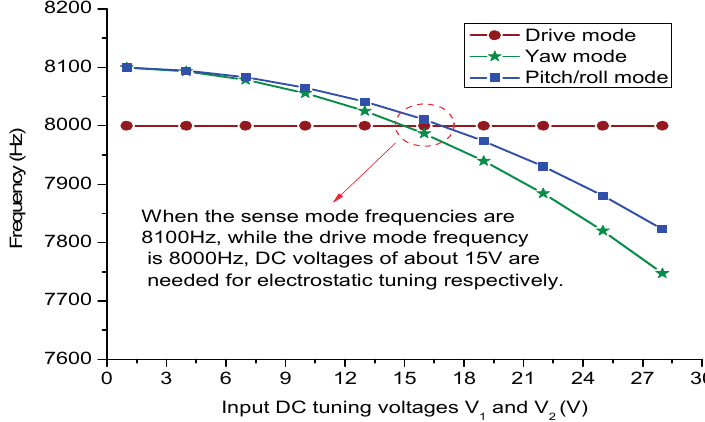
Figure 6. Electrostatic tuning simulation results of sense modes in